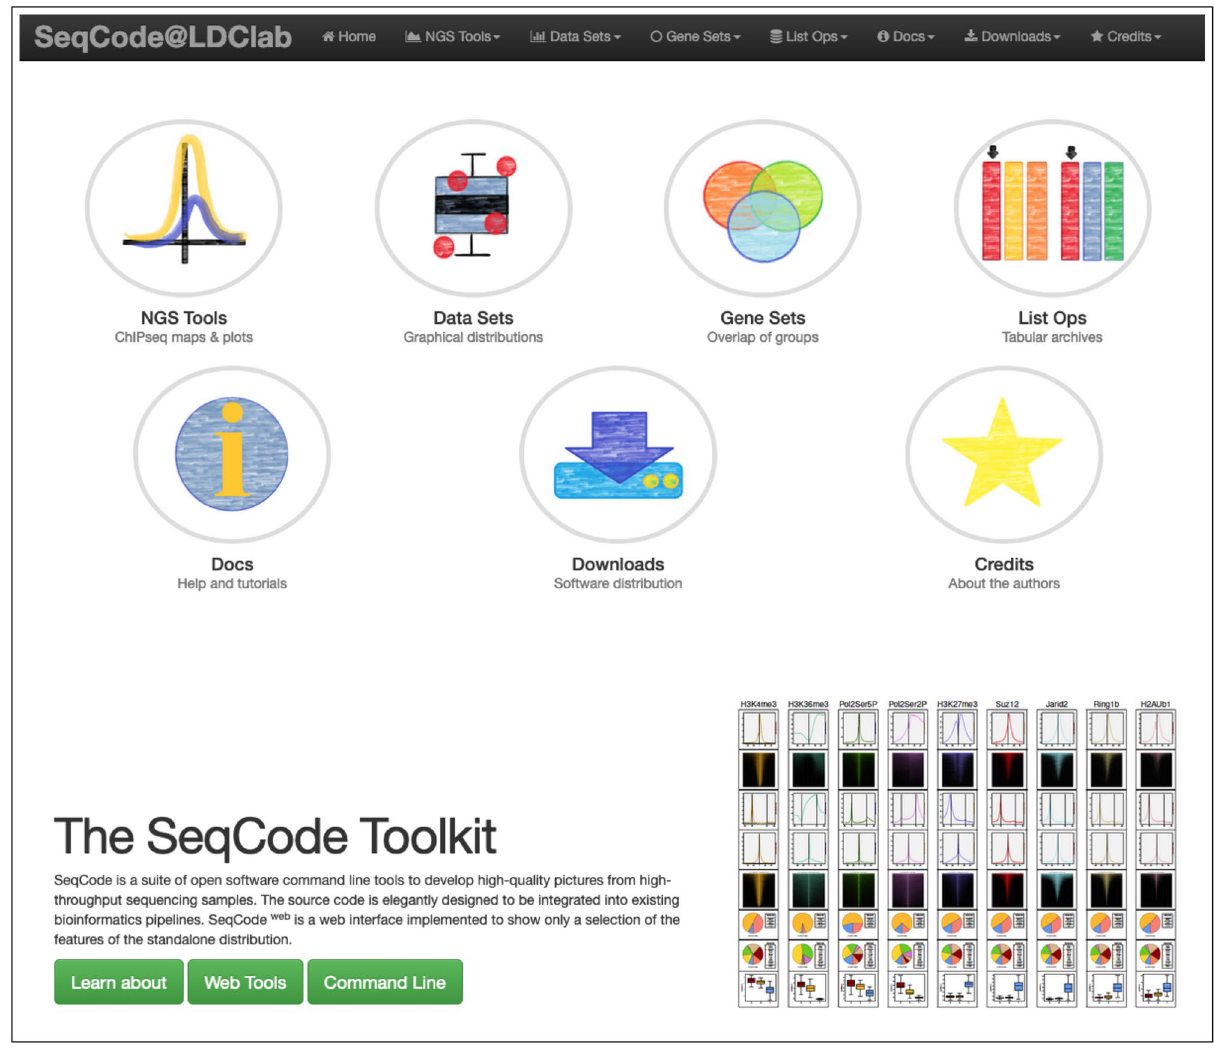
Figure 8. Homepage of the SeqCode website. The main menu of the web server is divided into four categories: NGS Tools (sequencing plots), Datasets (distribution plots), Gene Sets (intersection plots) and List Ops (operations with lists of identifiers). Additional help documentation and a section with downloading links are also provided